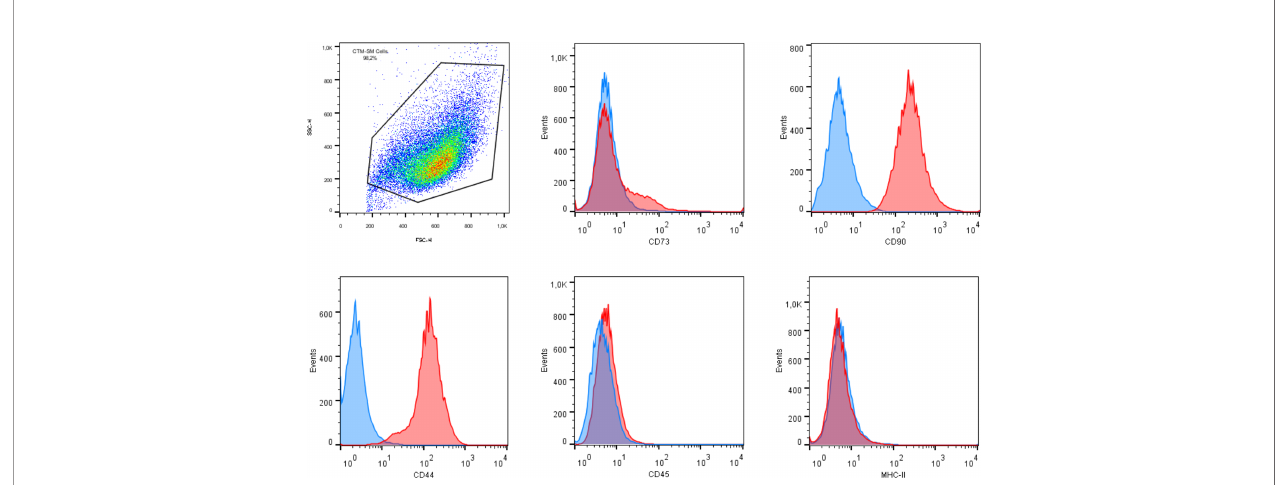
FIGURE 2 | Flow cytometry analysis of mesenchymal stem cell surface markers in synovial membrane derived MSCs revealing expression of CD90, CD44, and CD73, and lack of expression of CD45 and MHC class